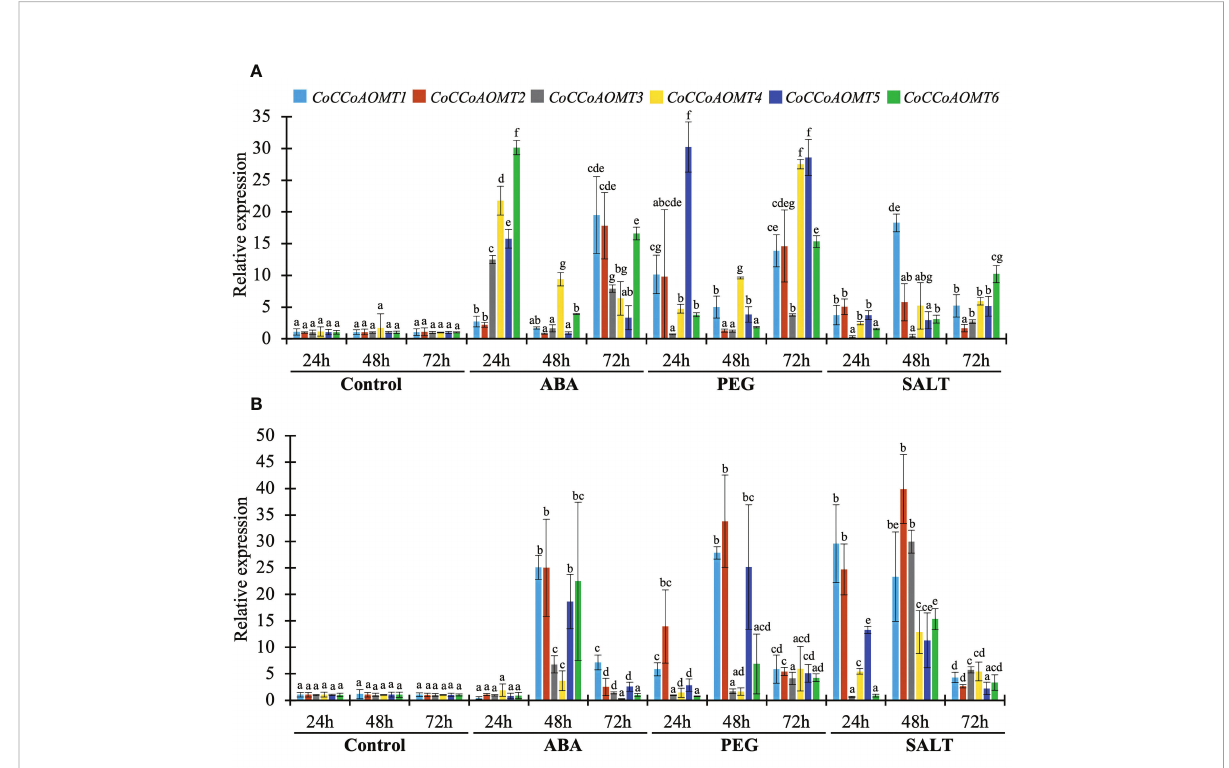
FIGURE 9 Expression pro fi les of CoCCoAOMT genes against control, hormonal, drought, and saline conditions. The left margin scale depicts the relative expression of CoCCoAOMT gene under control and various stress conditions. The results were reported as the mean value of the relative expression with standard deviation, using the jute Actin gene as a reference gene. Relative expression of CoCCoAOMT gene in C olitorius under control, ABA, PEG, and NaCl treatments in leaf (A) and stem (B) tissue. The expression level of each CoCCoAOMT gene at all three times under control condition was set to 1. Columns at each observation and time point followed by the different letters (such as a, b, c, d, e, f, or g) are statistically signi fi cantly different using the Analysis of variance test at P value ≤ 0.05, while columns with the same letter are statistically not signi fi cant (P value >